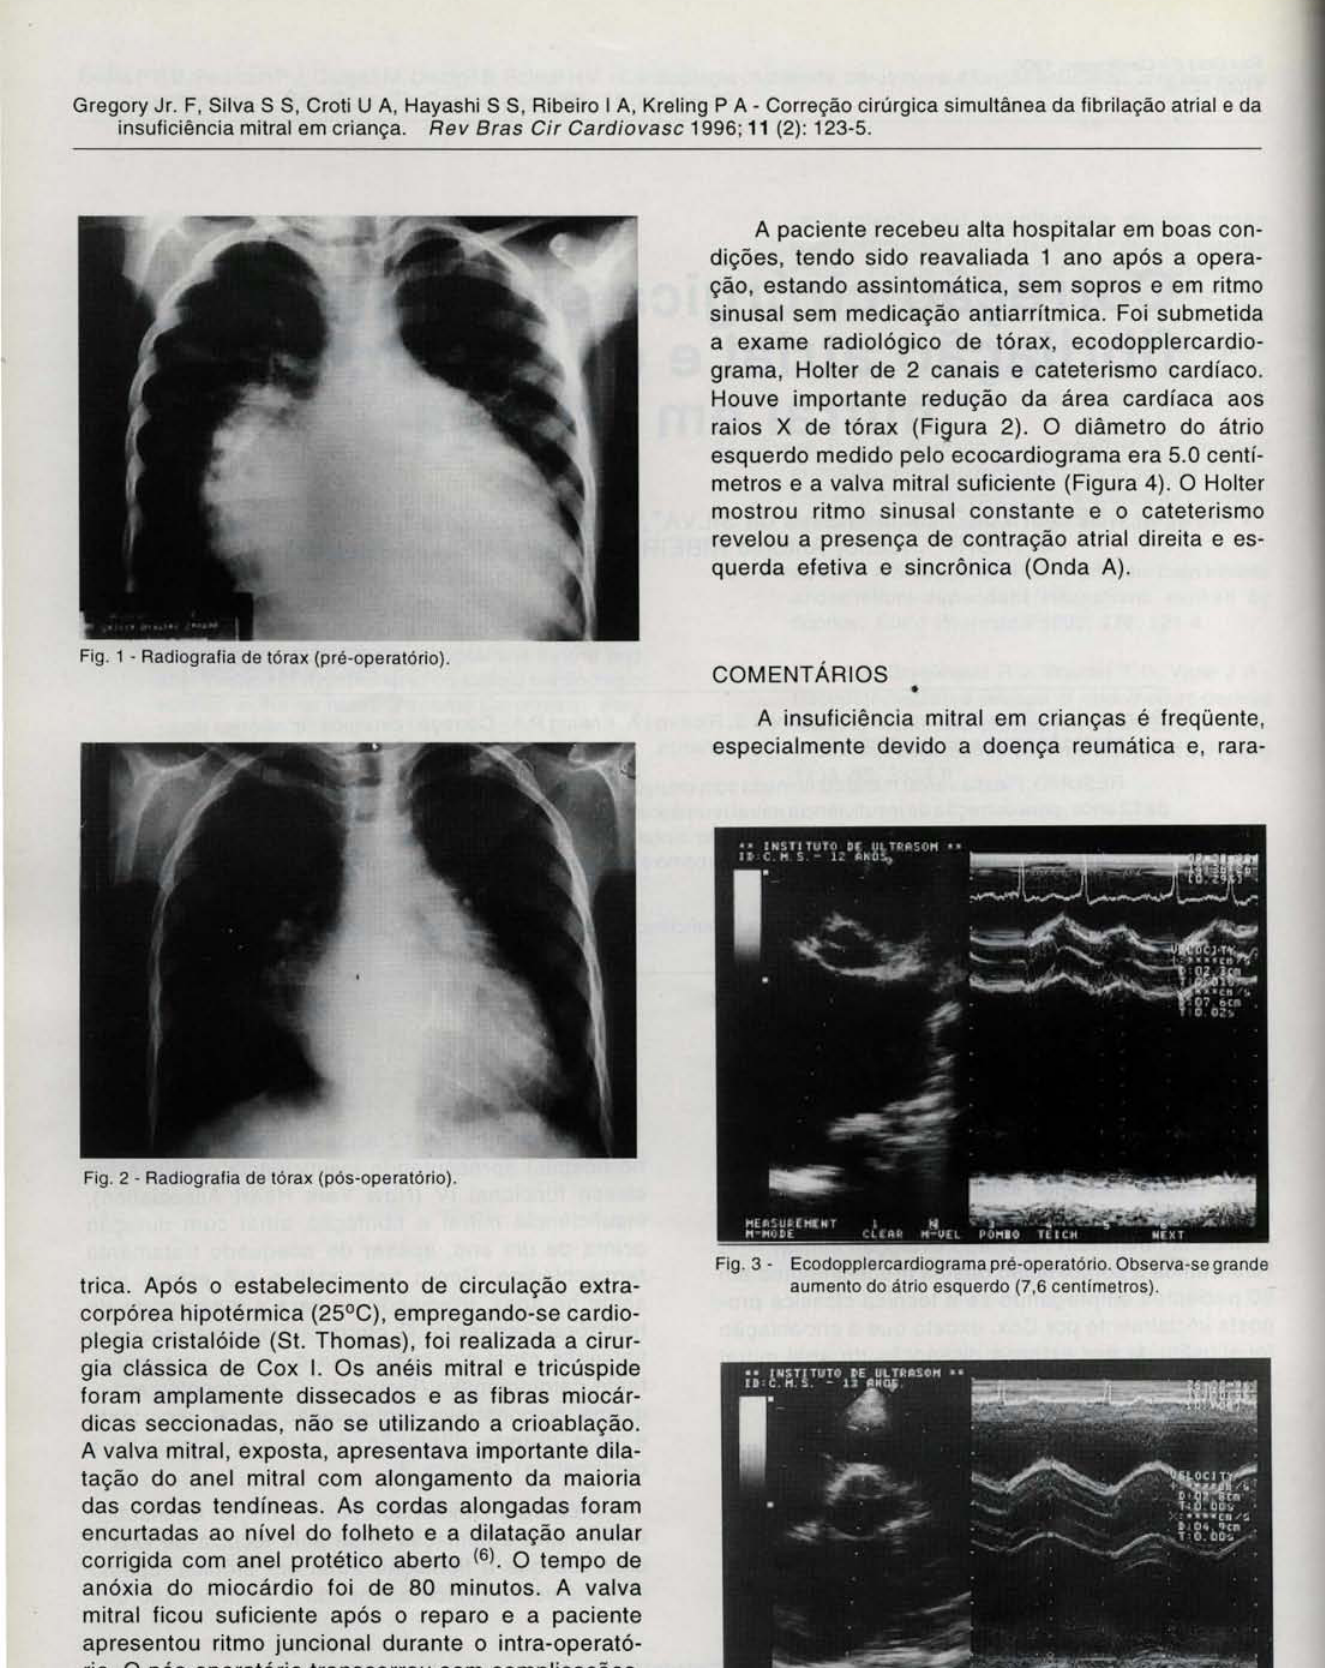
Fig. 3 · Ecodopplercardiograma pré·operatório. Observa-se grande aumento do átrio esquerdo (7,6 centimetros).